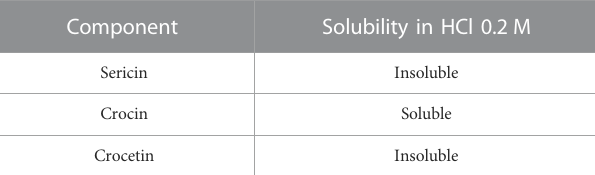
TABLE1Comparisonbetweenthe0.2 MHClsolubilitiesofthesubstancesused in the preparation of